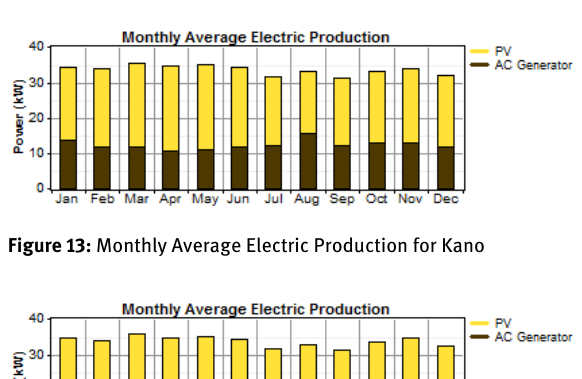
Figure 12: Monthly Average Electric Production for Enugu